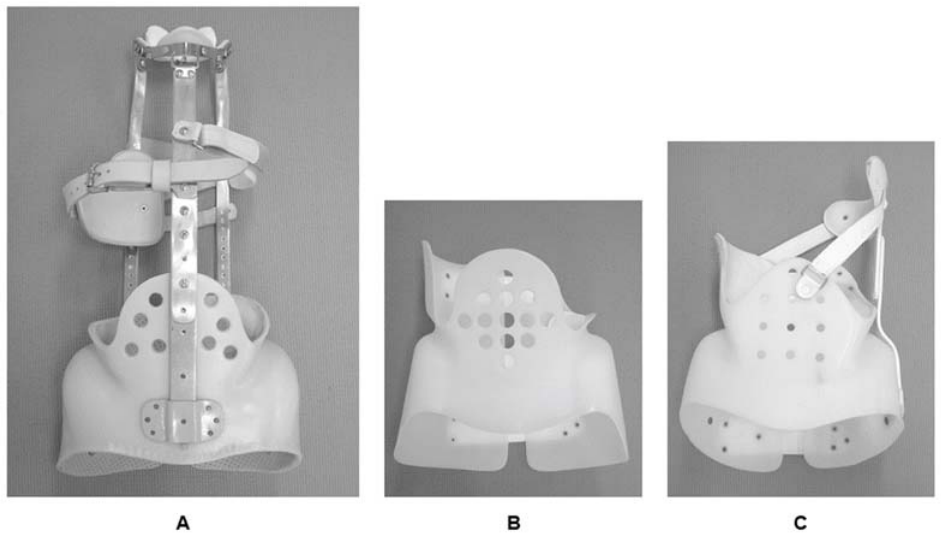
Figure 1. Various types of brace. ( A ) CTLSO (Milwaukee brace); ( B ) TLSO (Boston brace); ( C ) TLSO (Osaka Medical College: OMC brace).